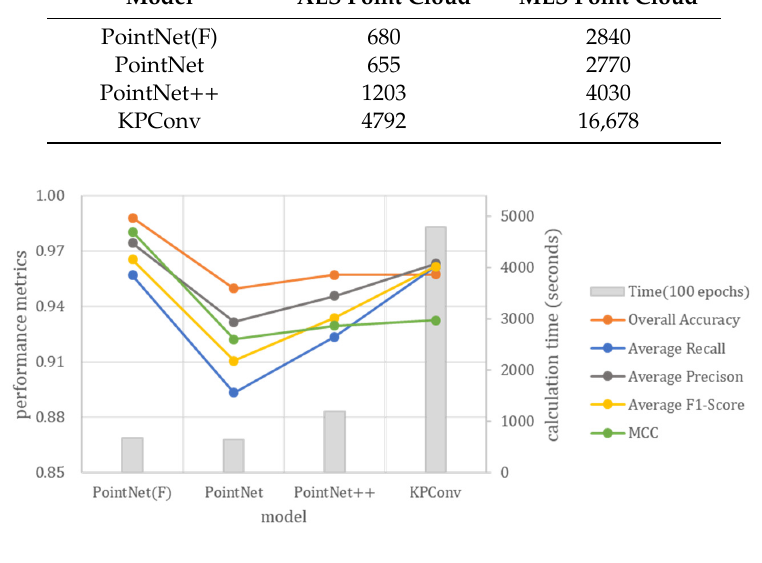
Table 13. Training time per 100 epochs of different models (seconds).